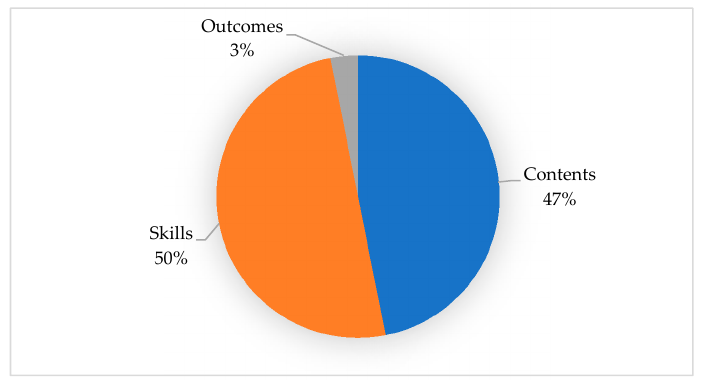
Figure 6. Elements considered for ICT-mediated assessment.